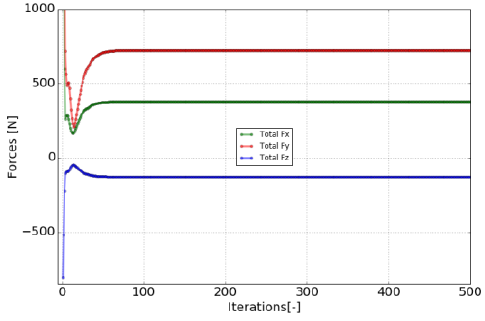
Figure 23. Typical solution convergence obtained by the Open-Source CFD configuration.